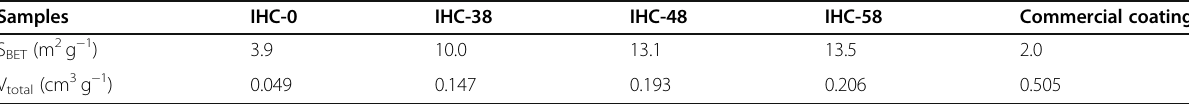
Table 1 Porous properties of IHC-s samples Samples